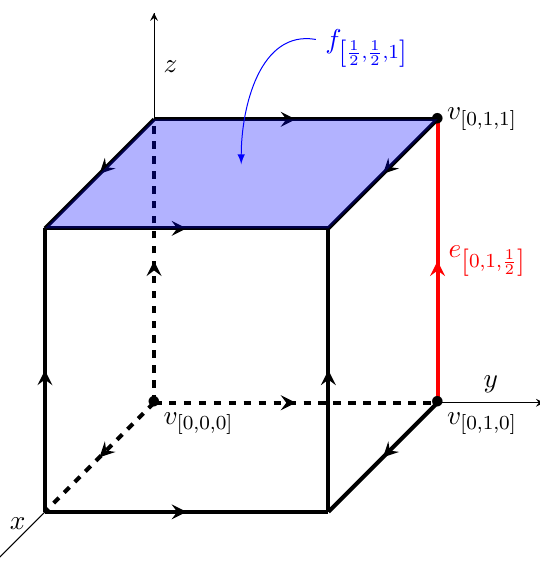
Figure 17 . The cubic lattice with chosen